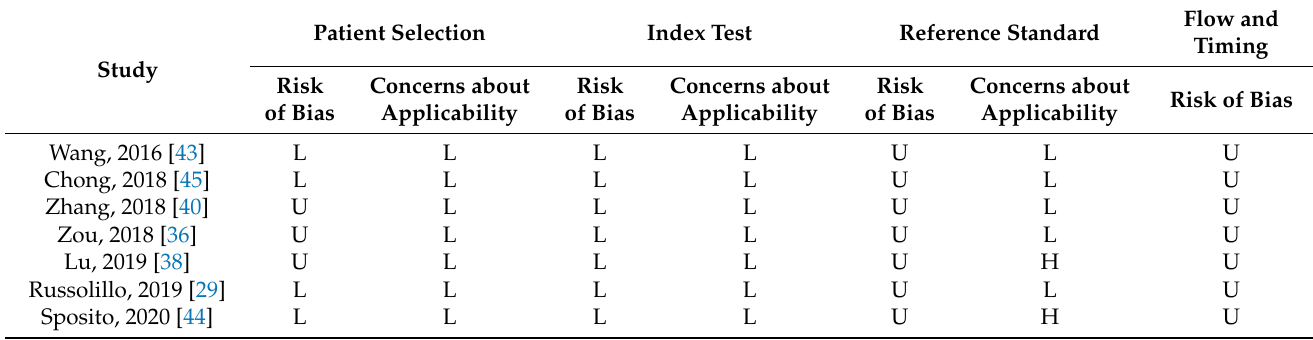
Table 2. The risk of bias and applicability concerns of the included